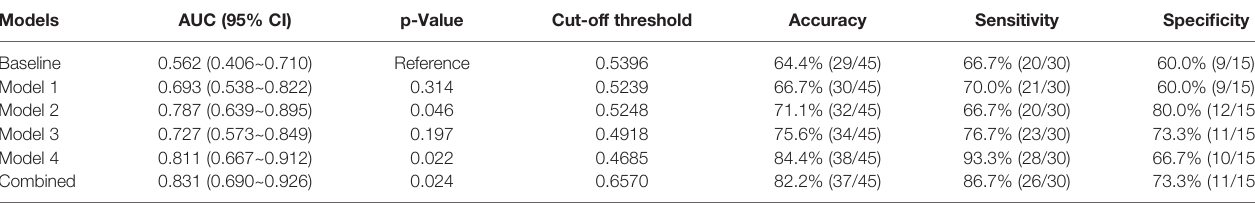
AUC, area under the